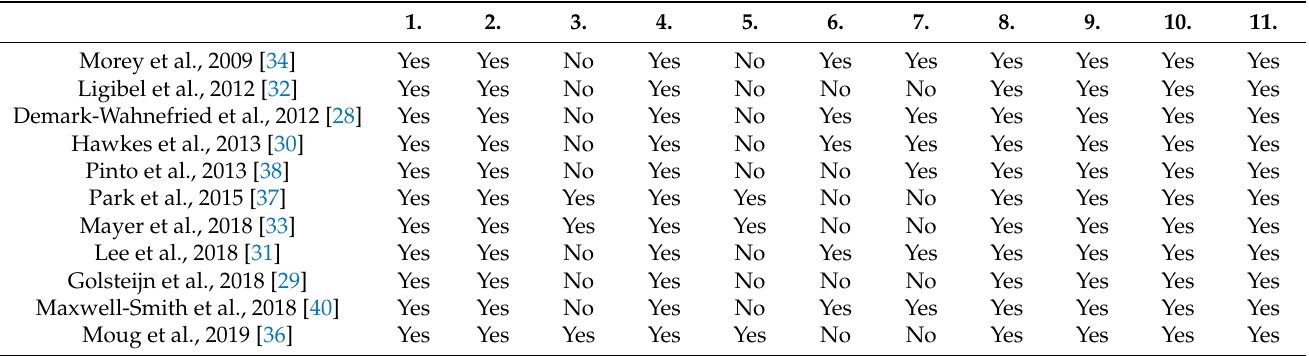
Table A1. The score in each item of the included studies based on the Physiotherapy Evidence Database